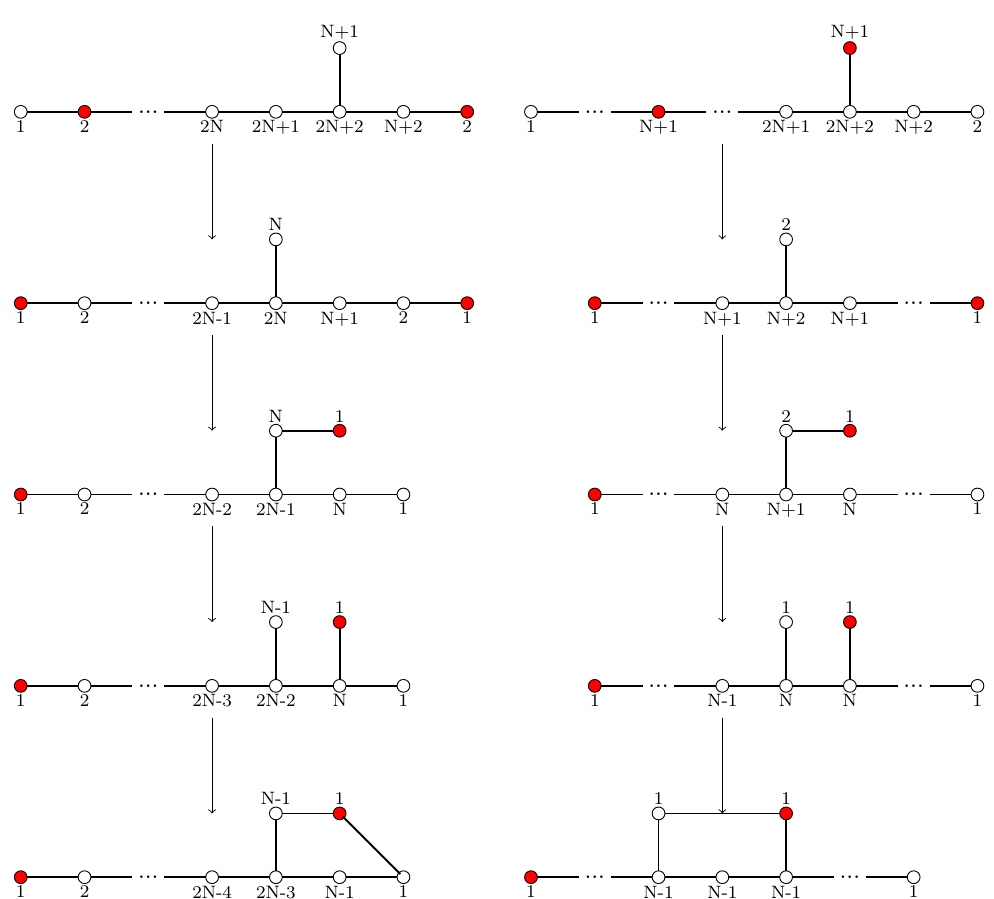
Figure 5. The decoupling trees for SU( N ) with 2 N + 3 − k flavors (on the left) and SU( N ) k +1 k − 1 2 with 2 N + 3 − k flavors (on the right). We exhibit explicitly all the deformations from k = 0 to 2 k = 4 . Notice that apart from the first decoupling we always turn on FI parameters at two abelian nodes and in this case the deformation is equivalent to a standard quiver subtraction. If we proceed further with the decoupling the Higgs branch becomes the union of multiple cones, each described by a quiver. With our procedure this arises because the magnetic quivers for k = 4 contain closed loops and therefore we have multiple choices for the set of bifundamentals for which we turn on a vev. The FI deformation leading to the k = 5 magnetic quivers is given